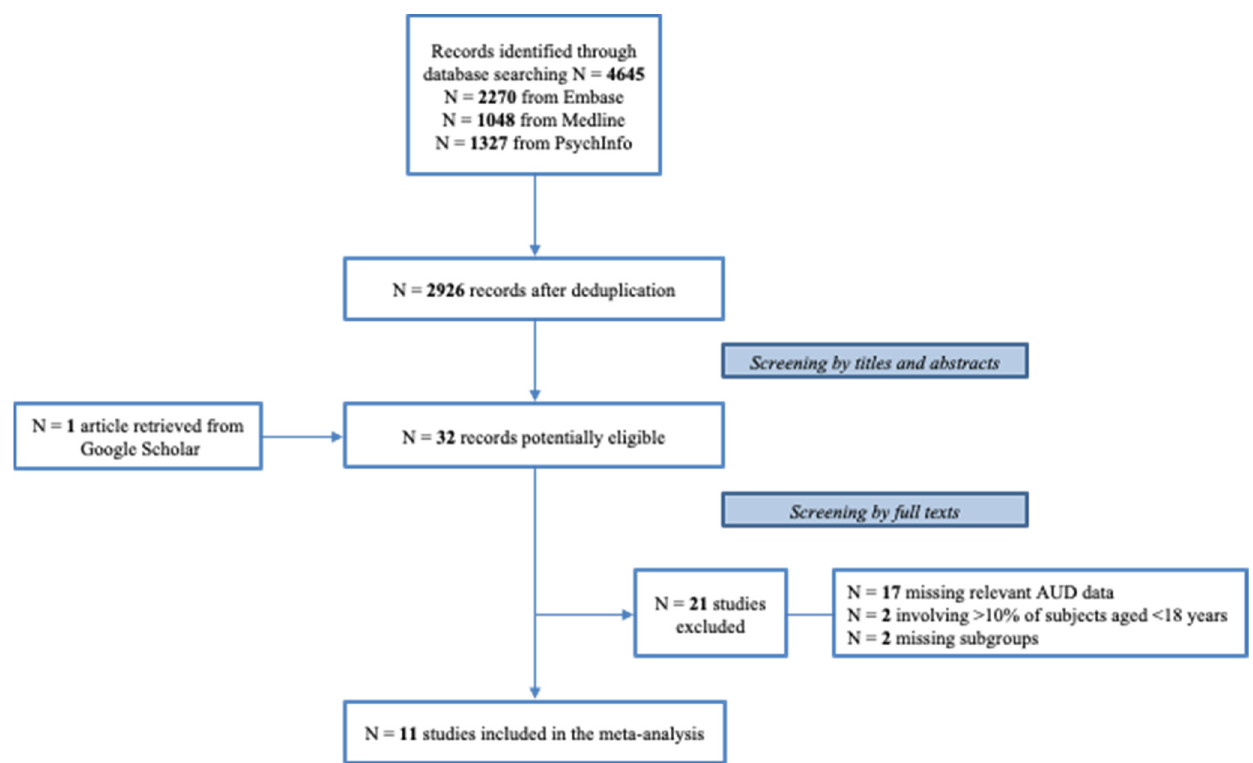
Figure 1. Flow chart of the included and excluded studies.